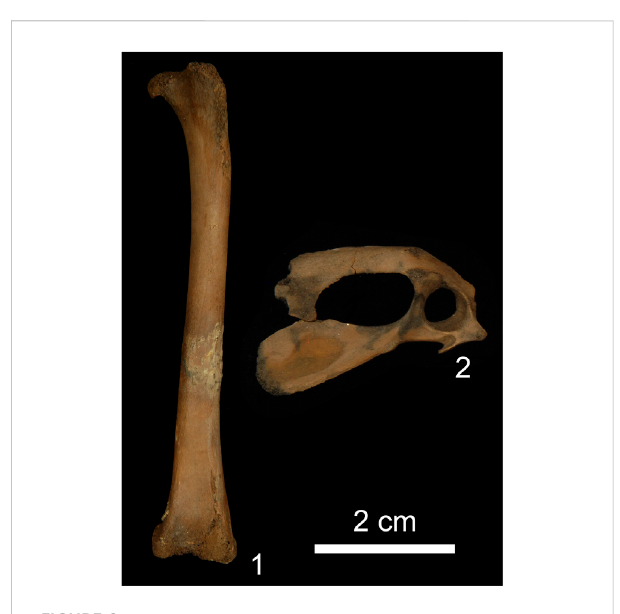
FIGURE 2 Studied immature Phasianidae bones from the Karako-Kagi site. 1: left femur; 2: right pelvis (fused ilium and